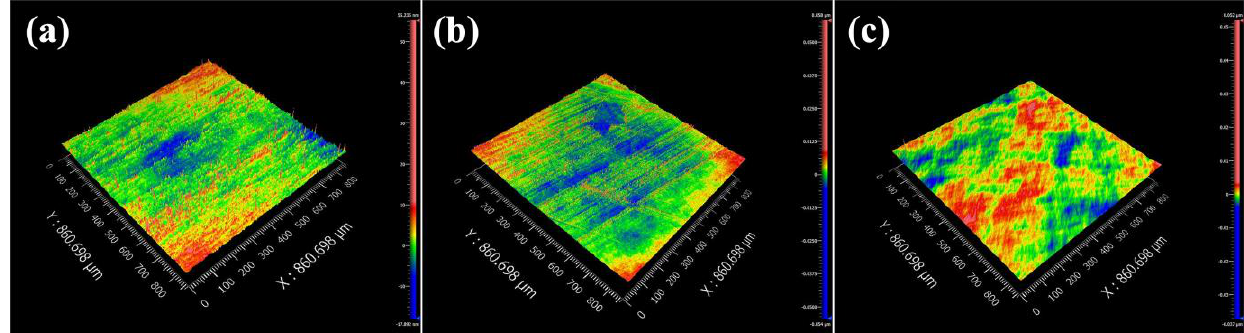
Figure 9. Interferometer images of TFT-LCD glass substrates polished by ceria-based abrasives. (( a ) F-abrasives; ( b ) S-abrasives; ( c ) N-abrasives).